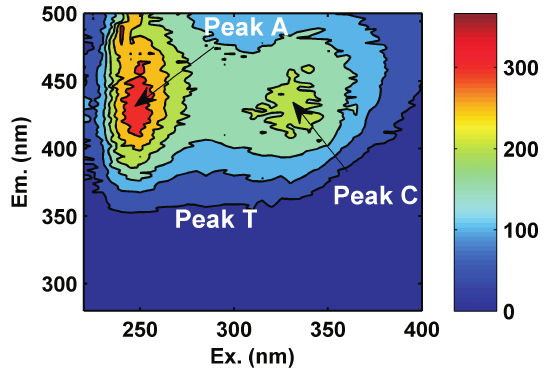
Figure 1. Fluorescence EEM of raw water. Fluorescence re- gions: fulvic-like fluorescence (Peak C), humic-like fluorescence (Peak A), tryptophan-like fluorescence (Peak